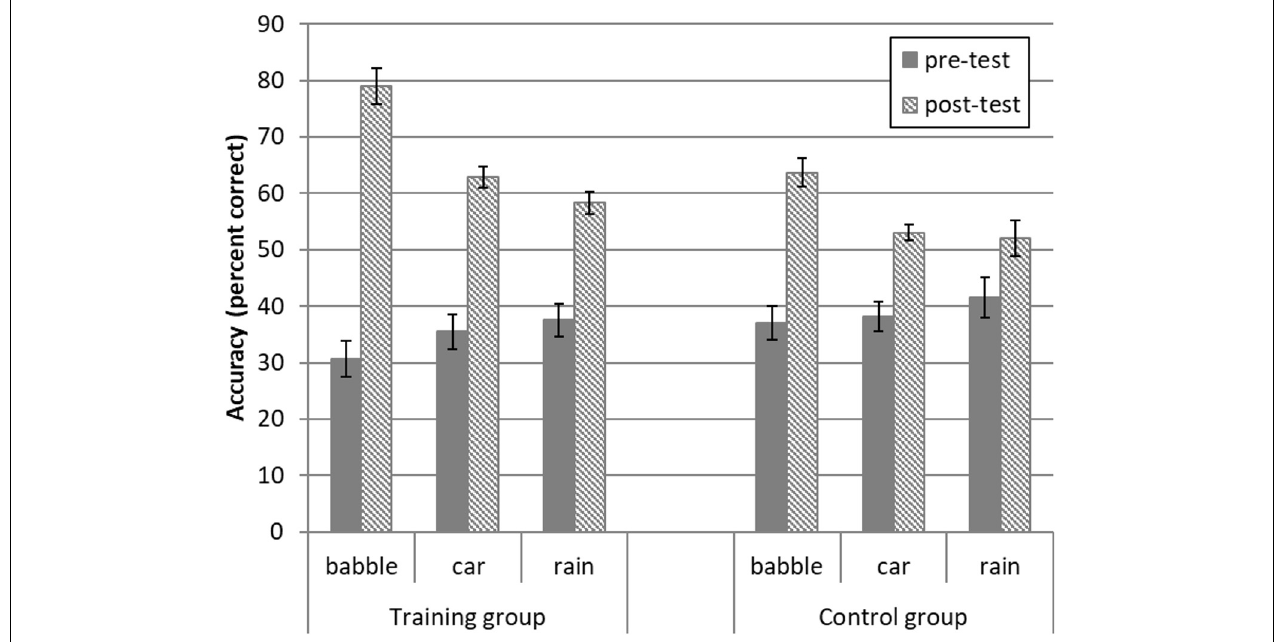
FIGURE 3 | Word identification accuracy (percent correct) for the training ( n = 12) and control ( n = 12) groups with three different background noises. Error bars reflect ± one standard